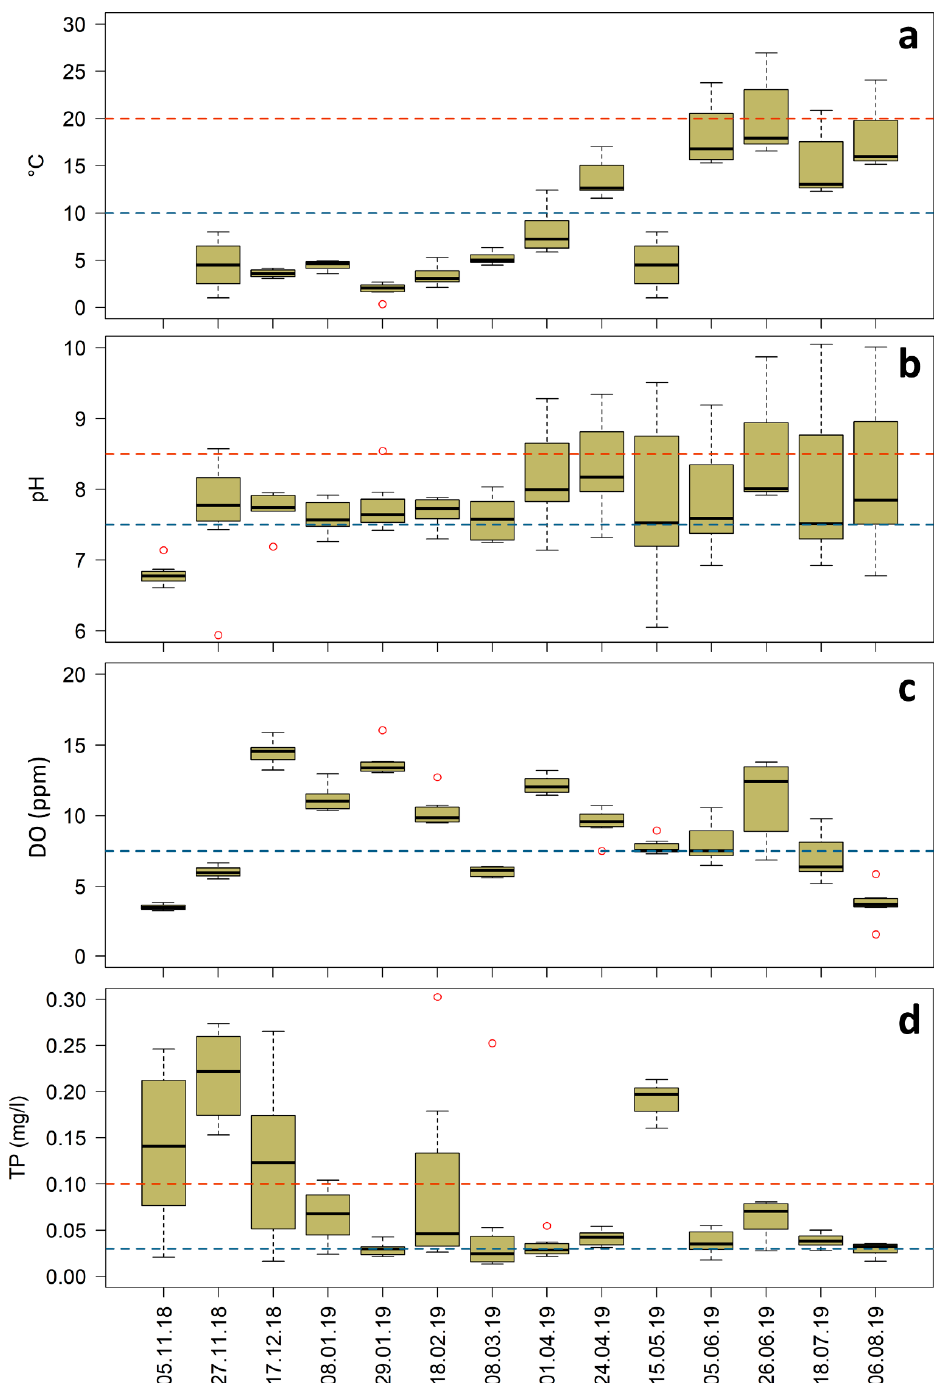
Figure 5. Time series of water quality data (n = 8 per date). Dashed lines represent thresholds for good ecological status according to OGewV (2016): ( a ) water temperature, winter maximum (blue line), and summer maximum (red line); ( b ) pH, minimum (blue line) and maximum (red line); ( c ) dissolved oxygen (DO), minimum; ( d ) total phosphorus (TP), threshold between good (<0.03 mg TP/l) and moderate ecological status (>0.03 mg TP/l; blue line), threshold between moderate and poor ecological status (>0.1 mg TP/l; red line).